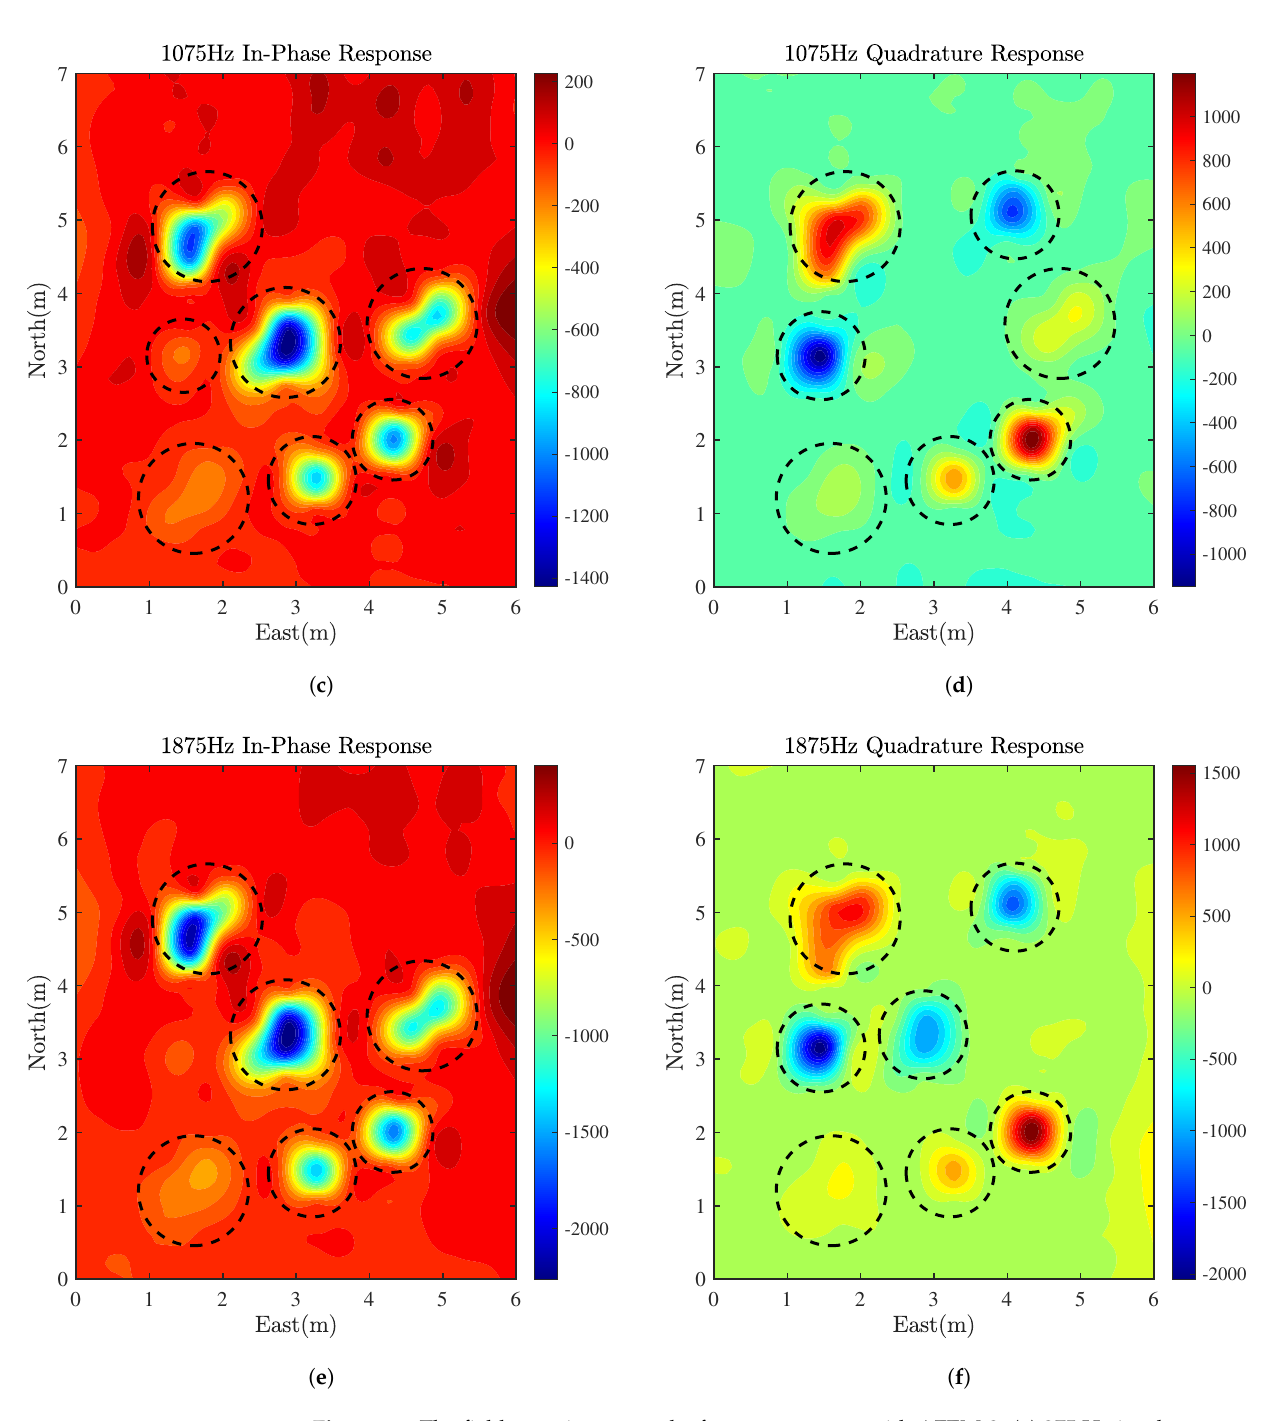
Figure 13. The field experiment results for a survey area with AFEM-3. ( a ) 275 Hz in-phase response; ( b ) 275 Hz quadrature response; ( c ) 1075 Hz in-phase response; ( d ) 1075 Hz quadrature response; ( e ) 1875 Hz in-phase response; ( f ) 1875 Hz quadrature